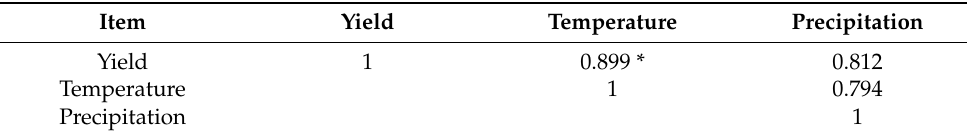
Table 1. The correlations between yields of essential oil and